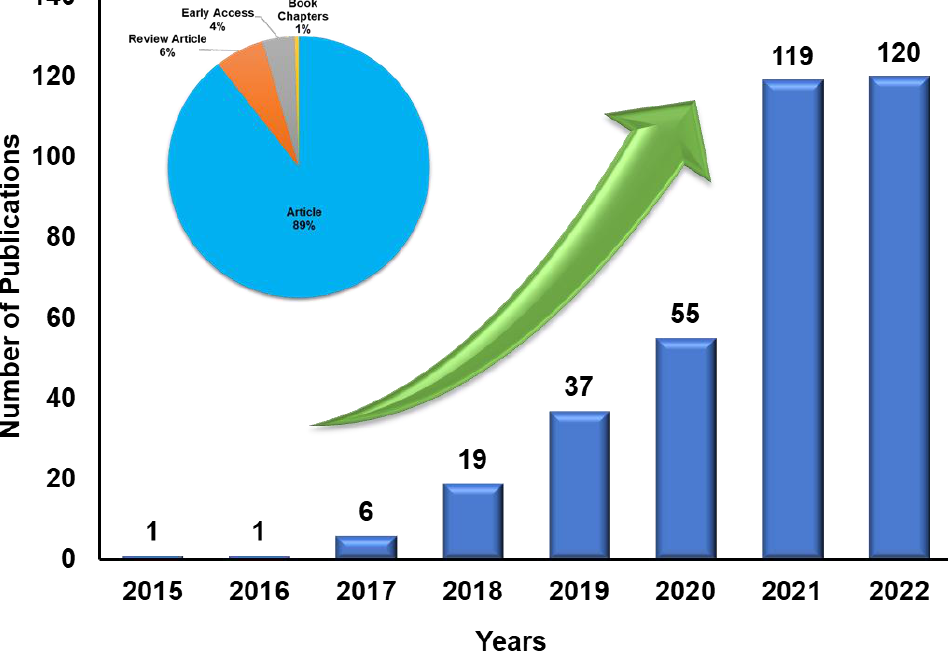
Figure 2. Various research publications during the last ten years toward HER (keywords: HER, MXenes). Source: Web of Science, https://www.webofscience.com/wos/woscc/summary/aa561b6b-209c-40c7-9557-00595d867918-62e97e6f/relevance/1, accessed on 14 November 2022.